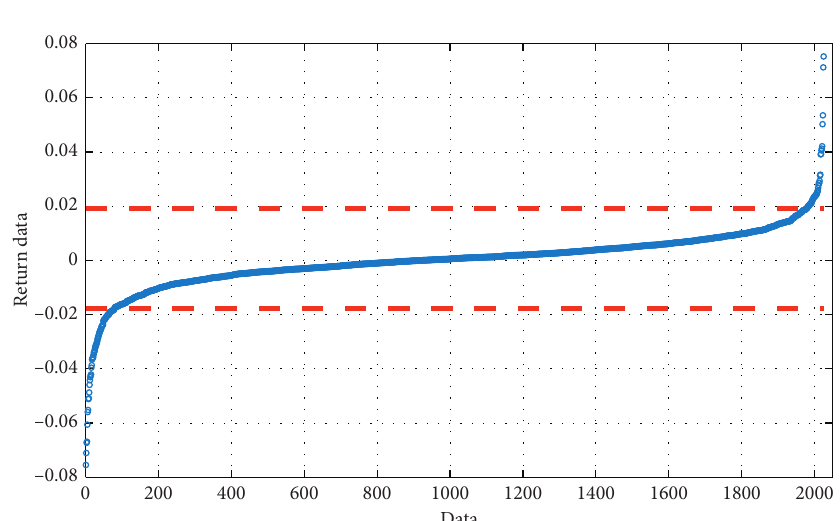
Figure 4: Return scatter plot based on Tukey method includes outlier